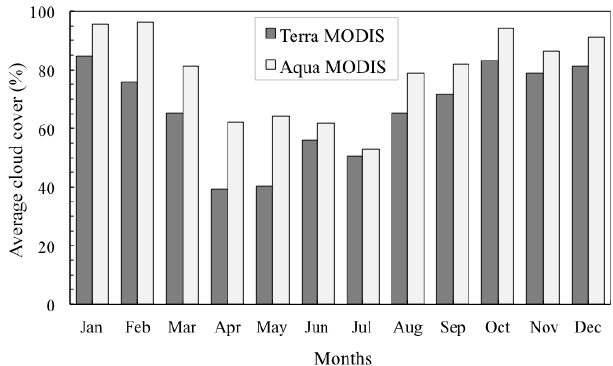
Figure 14. Proportion of pixels over the GoEA obscured by cloud in Terra (10:30LT) and Aqua (13:30LT) MODIS images. Monthly averages calculated from 1 January 2012 to 31 December